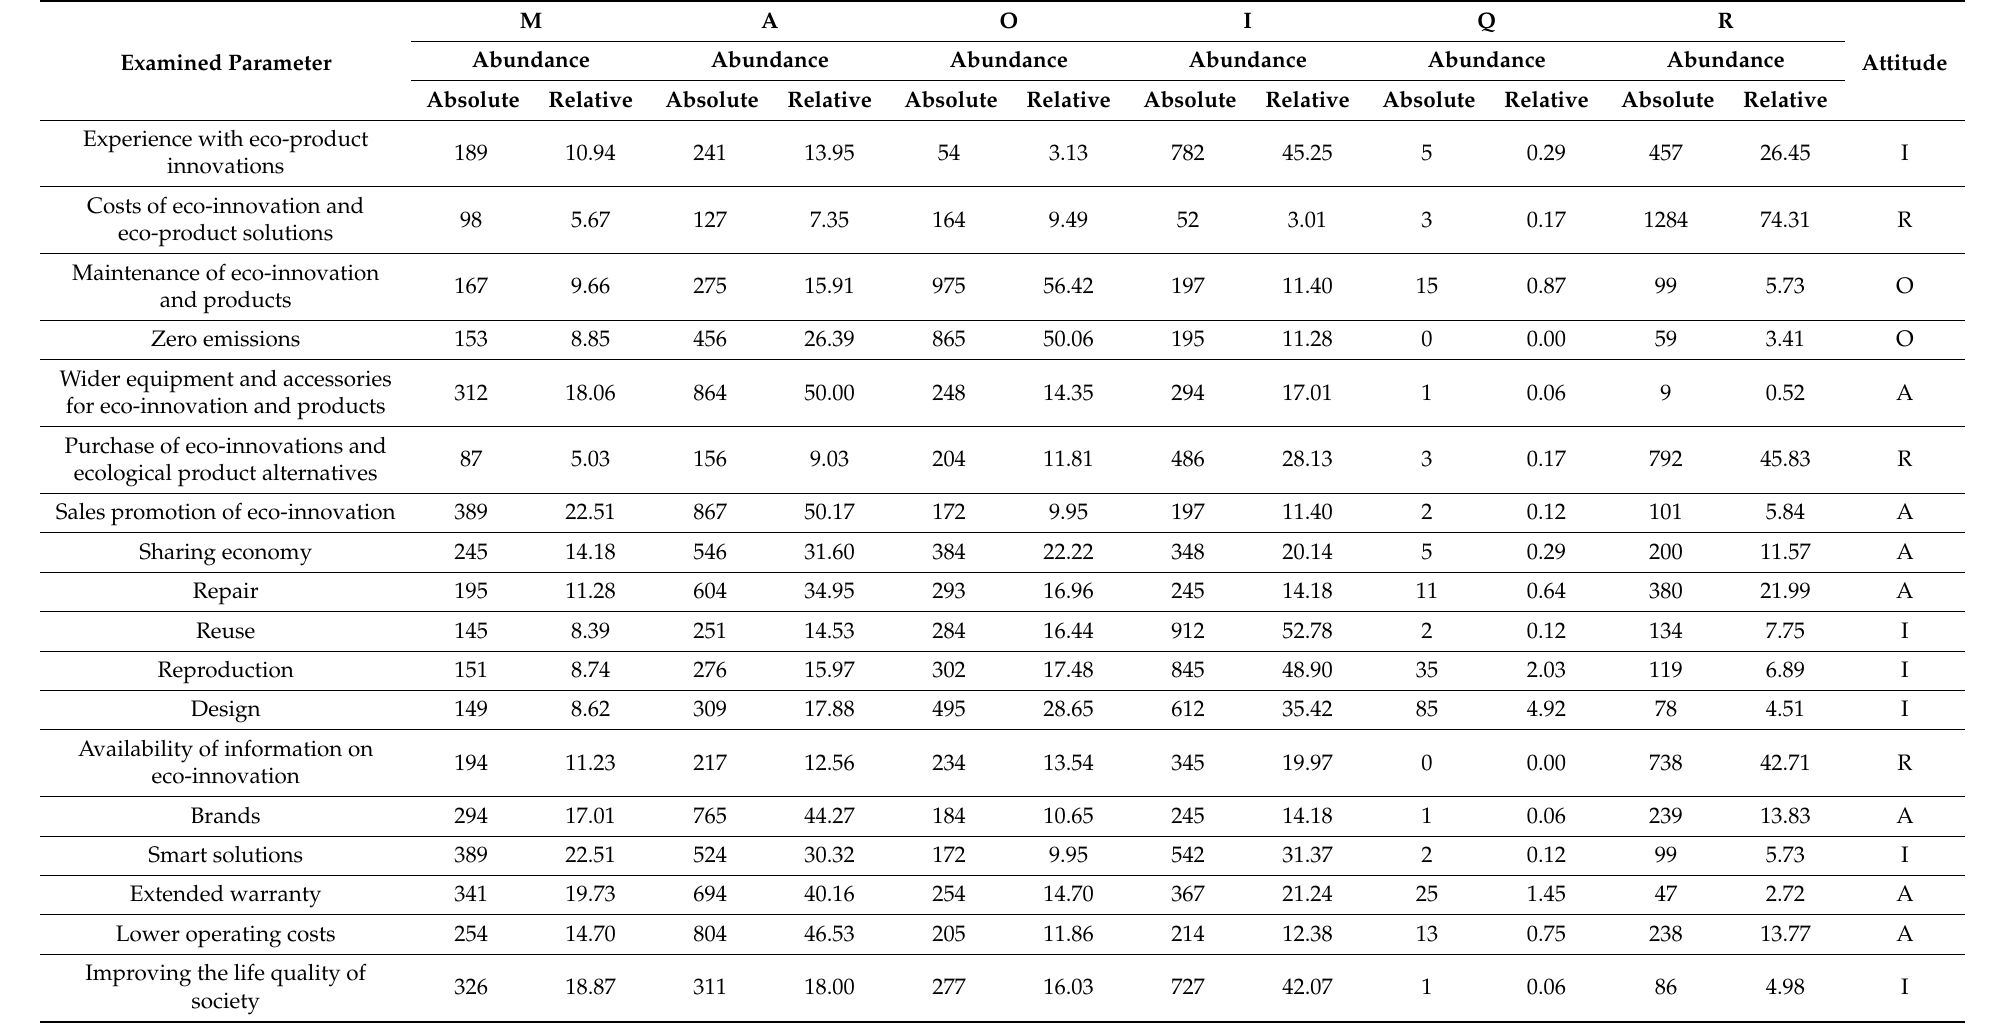
Table 3. Attitudes of Slovak respondents toward examined parameters through the Kano